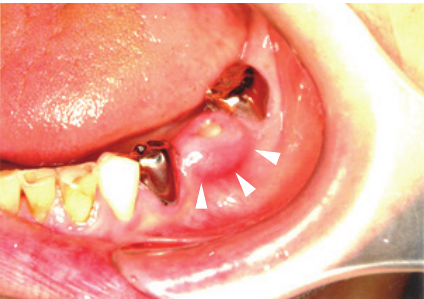
Figure 2: Intraoral photographic image taken in the first examina- tion. The bone is exposed from the alveolar crest of the lower left teeth 6 and 7, with swelling and redness in the surrounding